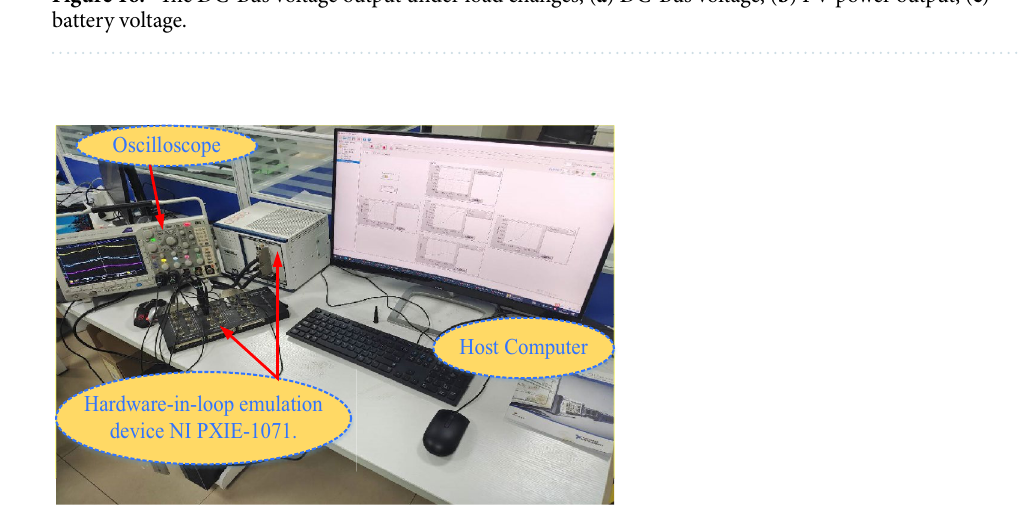
Figure 17. The configuration of Hardware-In-Loop (HIL)